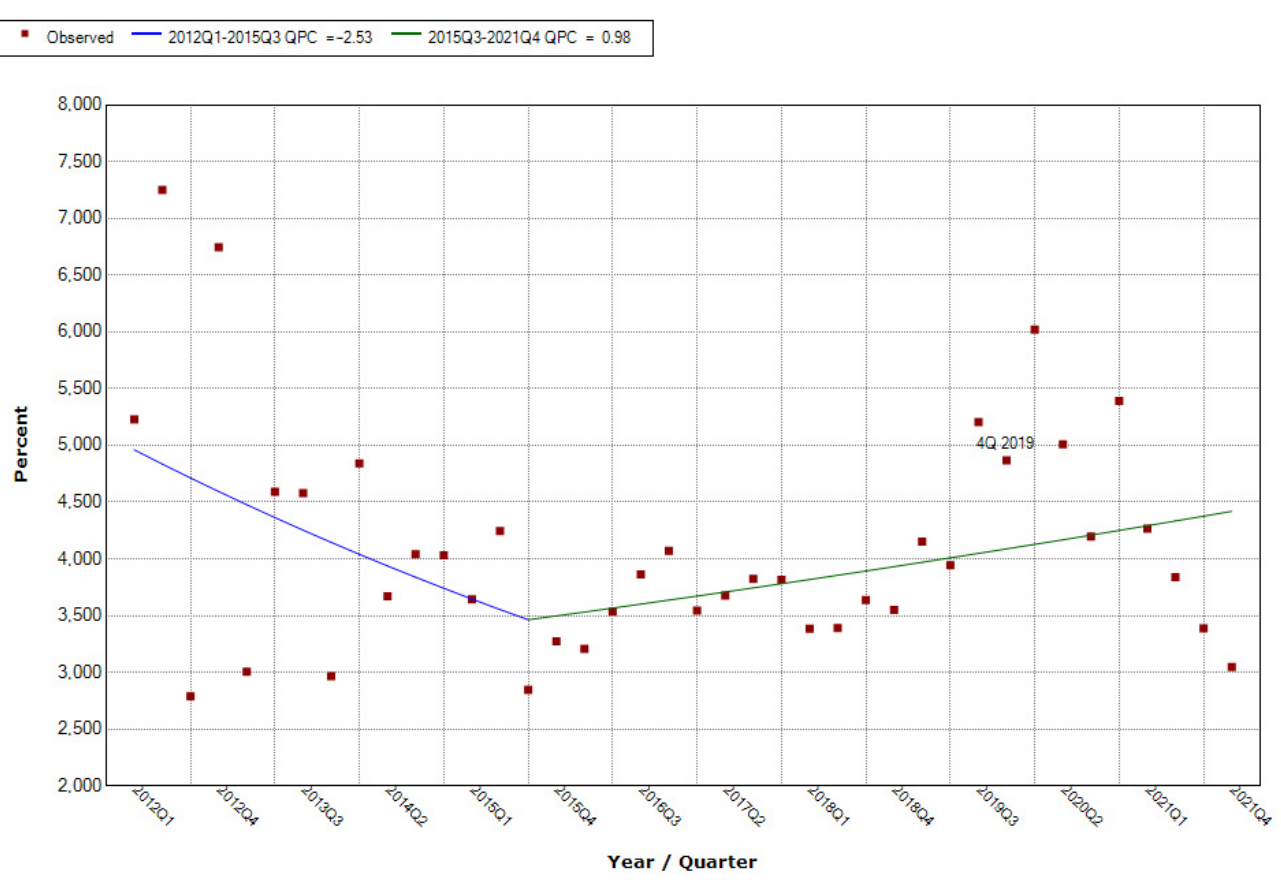
Figure A17. Percentage of products containing cooper in individual quarters in the period from 2012 to 28 November 2021. Joinpoints mark trend turning points. The date above the observation indi- cates the moment of publication of the scientific opinion/resolution.